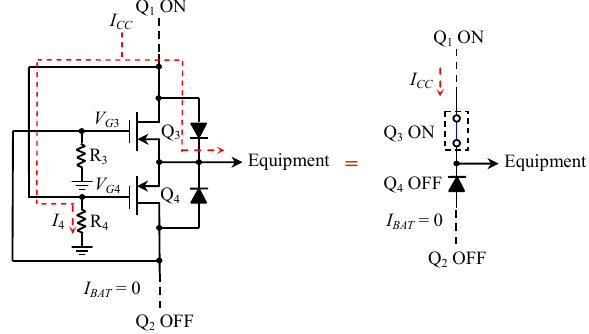
Figure 7. Mutual blocking circuit.